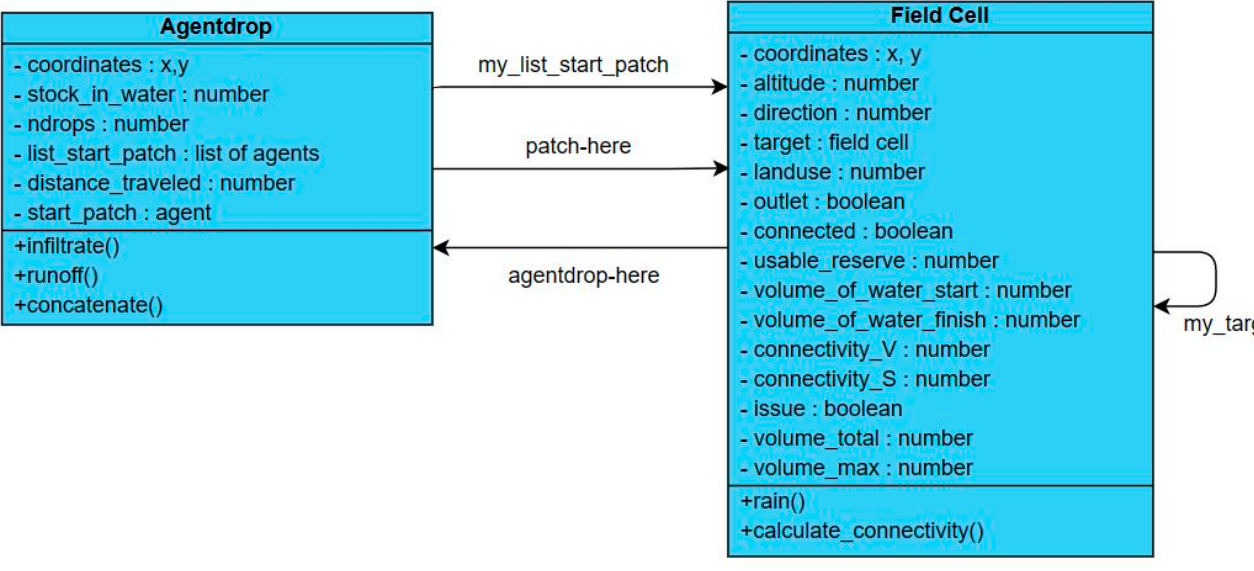
Figure 5. Class diagram describing the entities involved in the model.